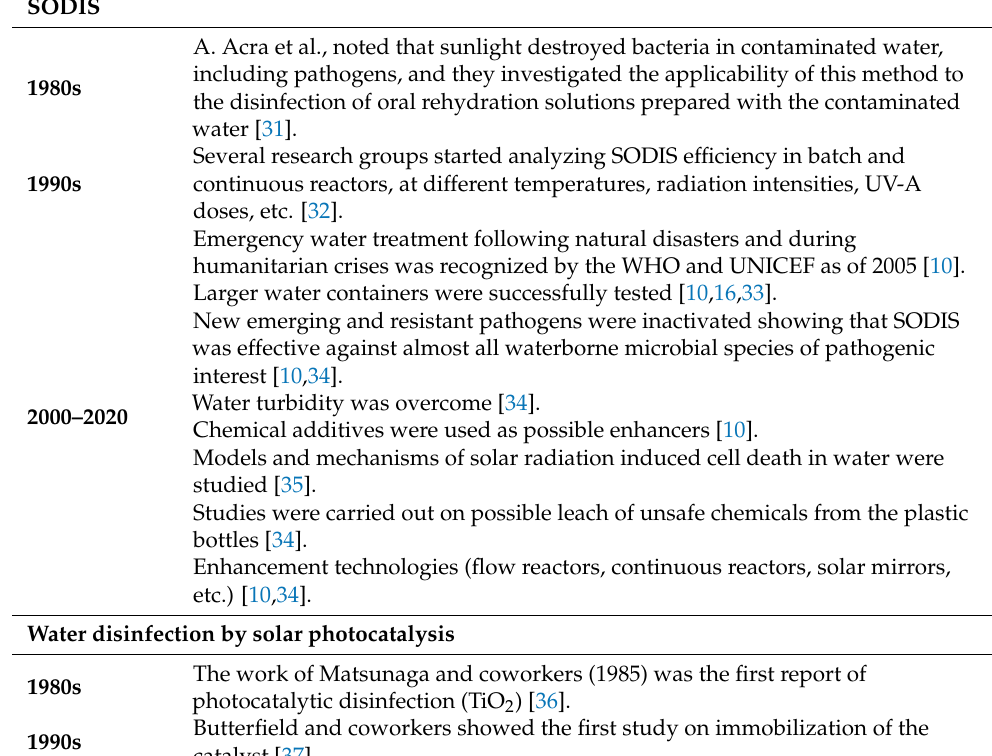
Table 1. Principal events, breakthroughs, and contributors for solar water disinfection (SODIS) (above) and water disinfection by solar photocatalysis